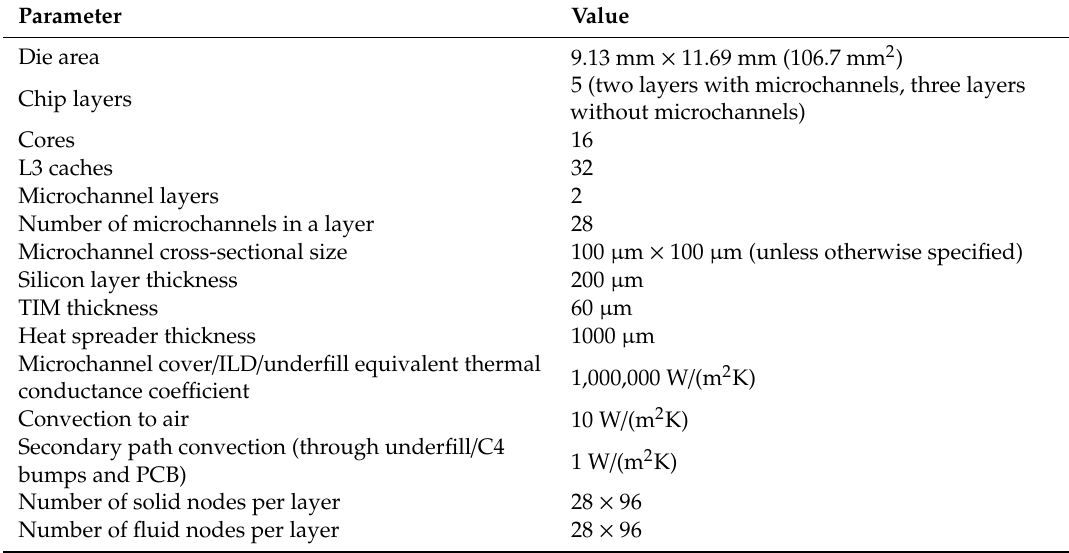
Table 1. 3D processor design